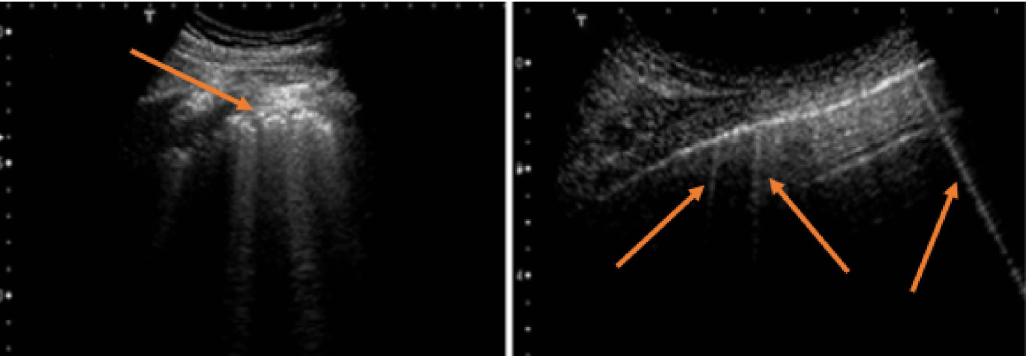
Figure 2. The image on the left shows vertical artifacts in a subject with idiopathic pulmonary fibrosis with a strongly irregular pleural line (red arrow). The image on the right shows B-lines (red arrows) with a regular pleural line in a subject with heart failure.